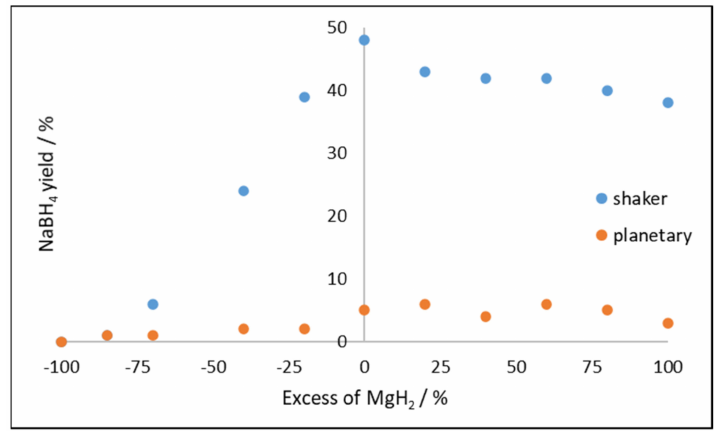
Figure 11. NaBH 4 dependence on the ball mill. Adapted from